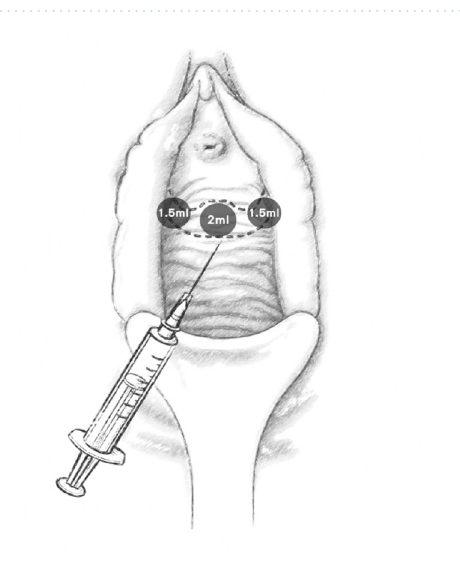
Figure 2. The clinical trial flowchart for platelet-rich plasma injection.